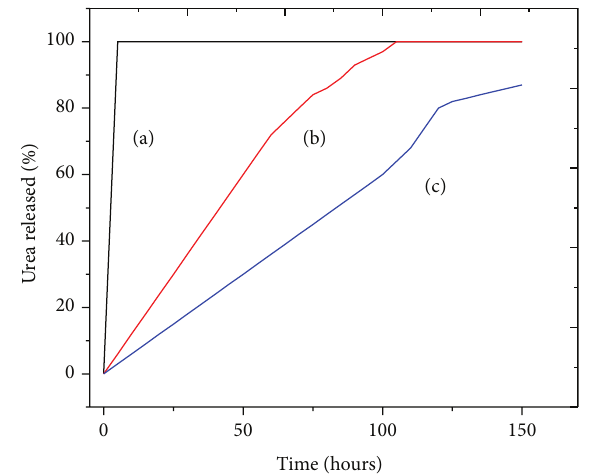
Figure 18: Release rate of (a) pure urea, (b) KPDMU, and (c) KPDMUG as a function of time at pH 7 and room